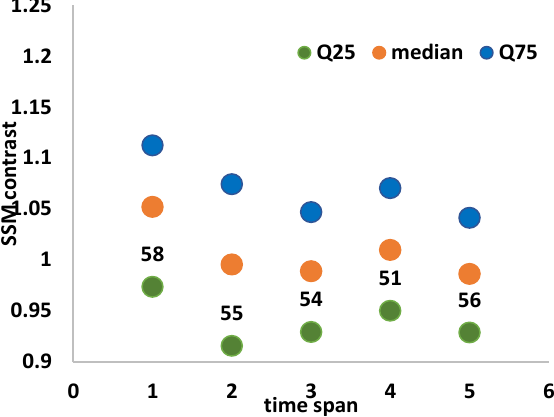
Figure 11. As for Figure 8, but for maize fields.